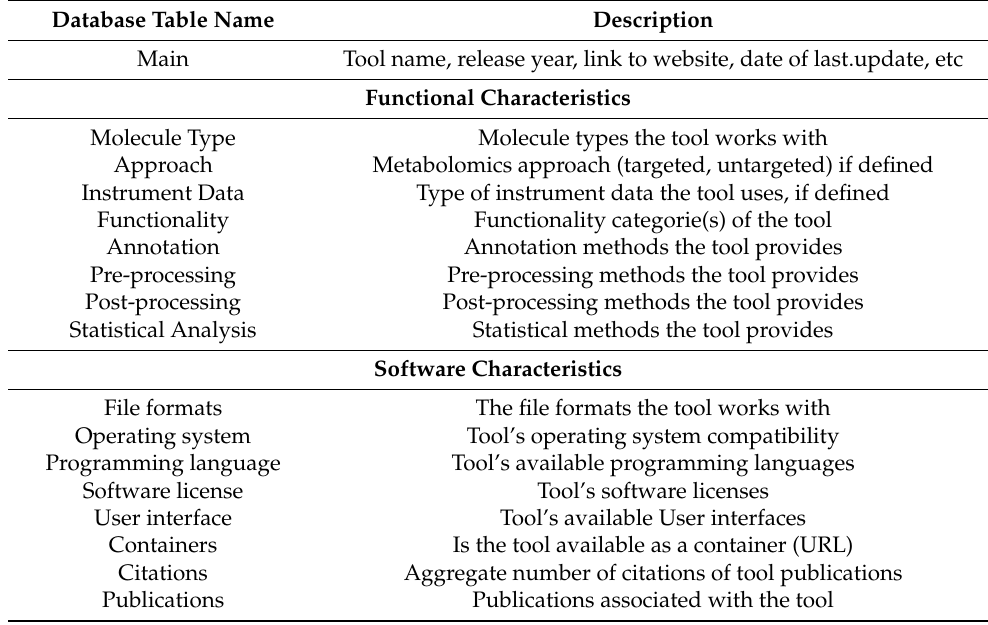
Table 2. Structure of the MSCAT database consisting of 17 tables and their descriptions.